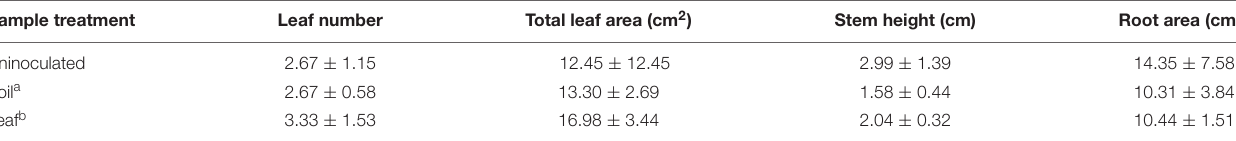
FIGURE 1 | Phylogenetic tree of Pantoea sp. YR343 and related species within Enterobacteriaceae . Partial nucleotide sequences from atpD , infB , gyrB , and rpoB were used for multi locus sequence analysis. TABLE 1 | Effect of wild type Pantoea sp. YR343 on Populus deltoides WV94 growth. Sample